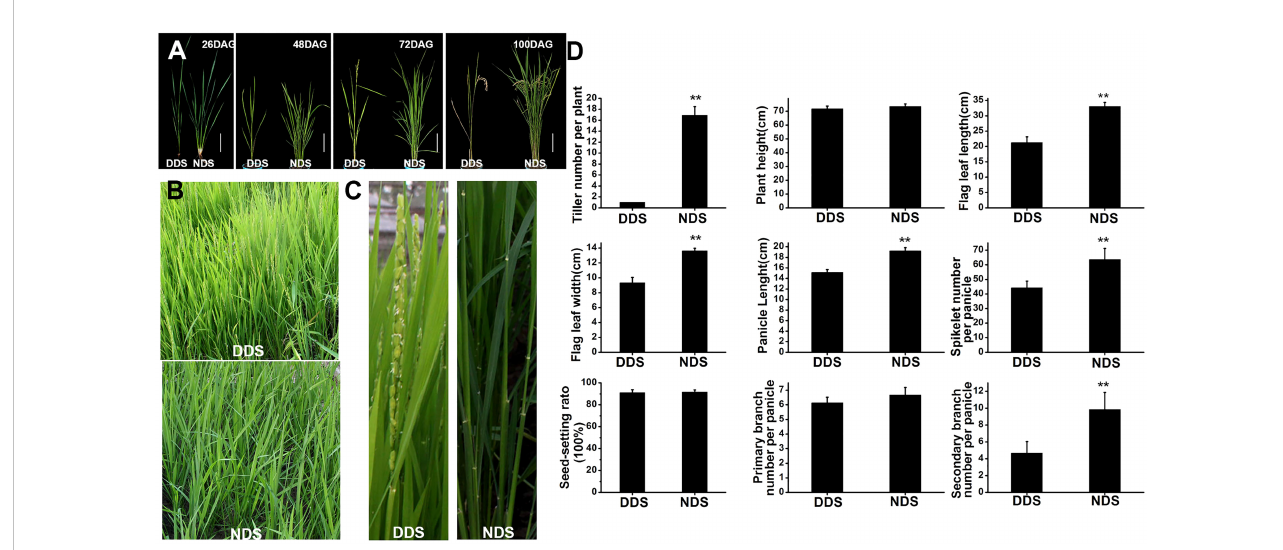
FIGURE 1 DDS plants exhibit constitutive SAS. (A) Comparison of the tiller at different stages under DDS or NDS conditions. 26, 48, 72, 100 DAG treatment were photographed. Bar = 15 cm. (B, C) Earlier heading dates and yellow leaves were observed in DDS at 72 DAG. (D) Agronomic traits in these plants. Data represent the mean ± SD of three biological replicates (Student ’ s t test: **P ≤